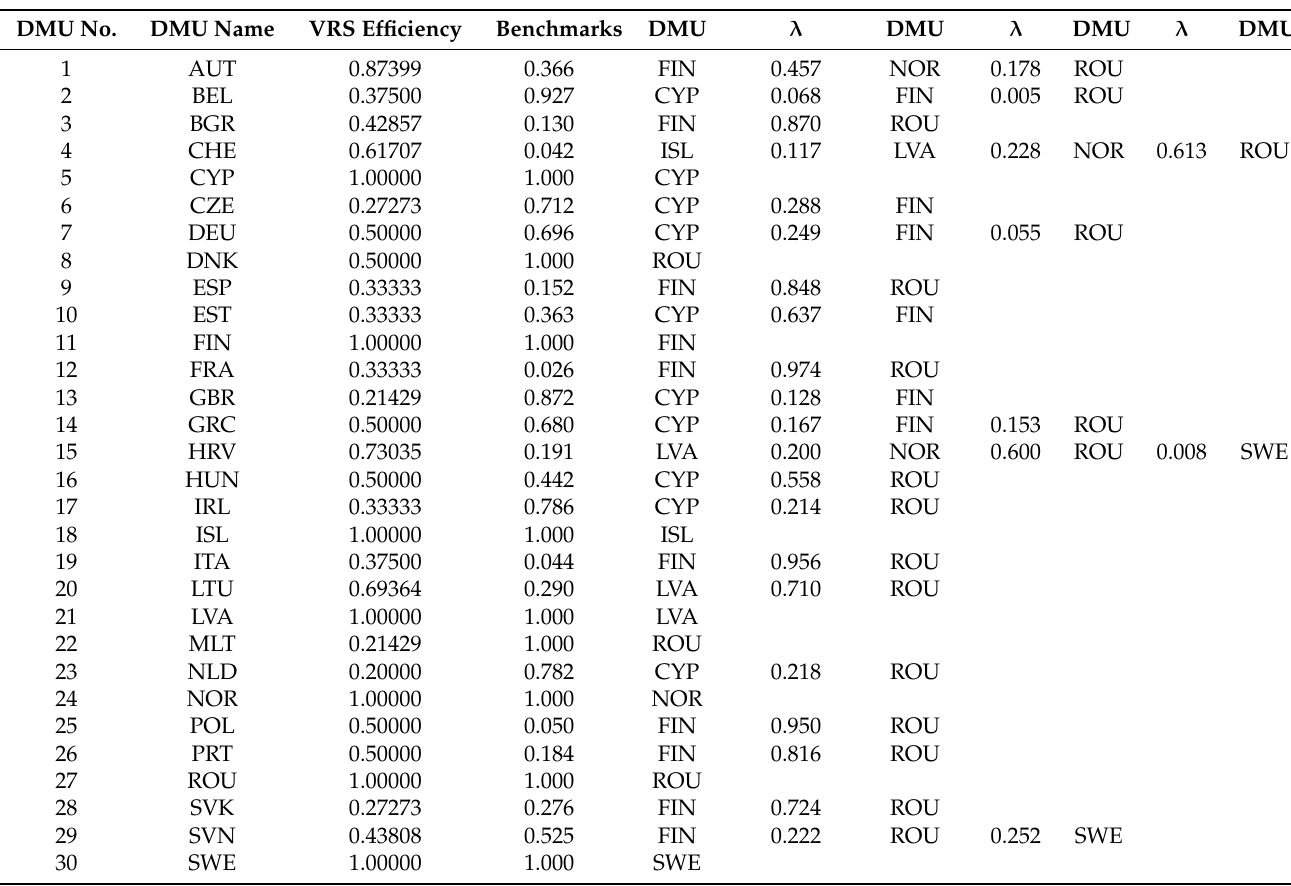
Table A20. Input-Oriented VRS Efficiency of EPS in 2005. Source: Authors’ calculations in DEAFrontier. DMU